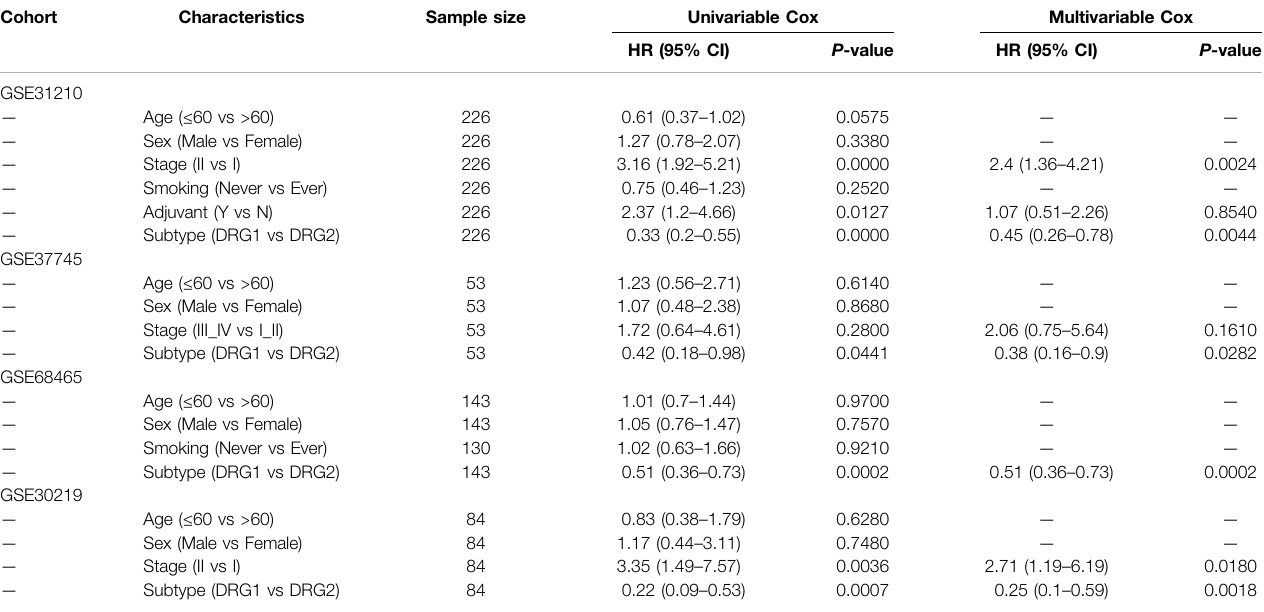
TABLE 3 | Univariable analysis and multivariable Cox regression analyses of DFS in four validation cohorts.